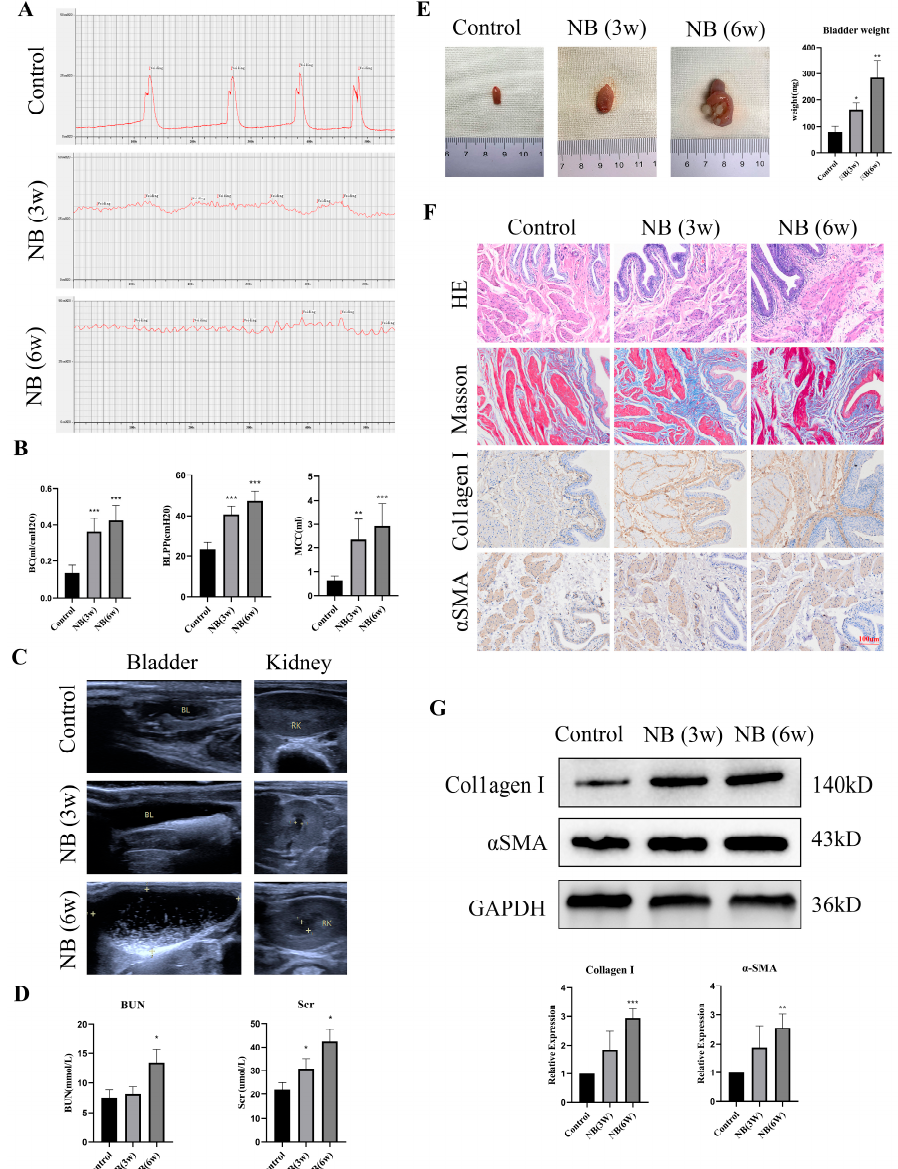
Figure 1. Bladder dysfunction, upper urinary tract damage, and bladder fibrosis at different times 1 after SCI. ( A ) Cystometry in rats at different time points after SCI. ( B ) Comparison of cystometric parameters (BLPP, BC and MCC) in different groups of rats. ( C ) Ultrasound images of the bladder and kidney in different groups of rats. ( D ) Serum BUN and Scr levels in different groups of rats. ( E ) The bladder weight of rats in different groups. ( F ) HE, Masson and immunohistochemical staining of rat bladder after SCI for three and six weeks. ( G ) Collagen I and α SMA protein levels determined through Western blotting. Data are presented as the mean ± S.D. (n ≥ 3). * p < 0.05; ** p < 0.01; *** p < 0.001. Scale bars, 100 µ